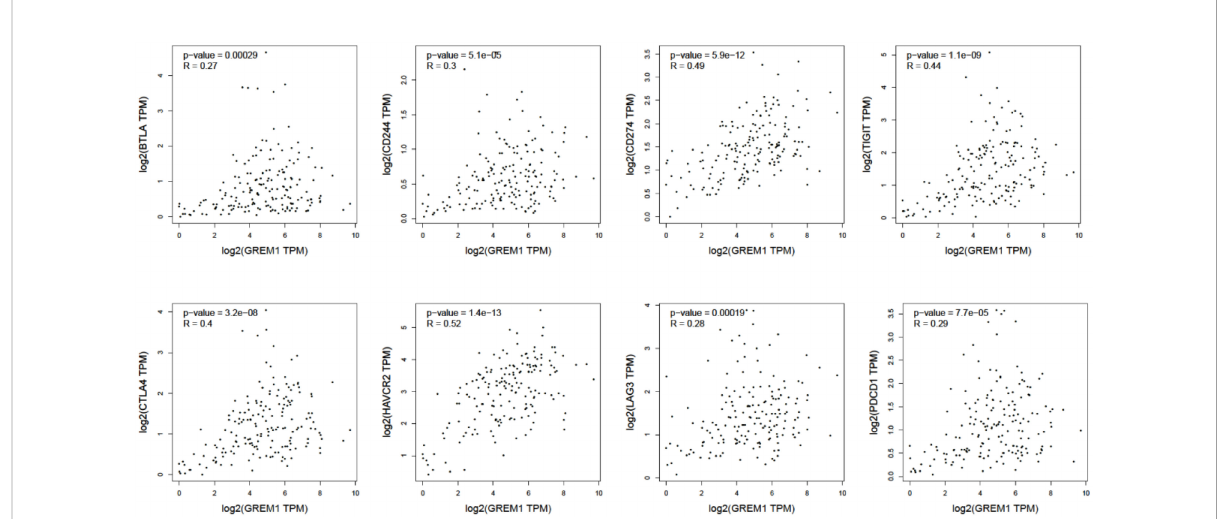
FIGURE 8 The positive relationship between GREM1 expression and several surface markers concerning T-cell exhaustion (BTLA, CD244, CD274, TIGIT, CTLA4, HAVCR2, LAG3, and PDCD1).